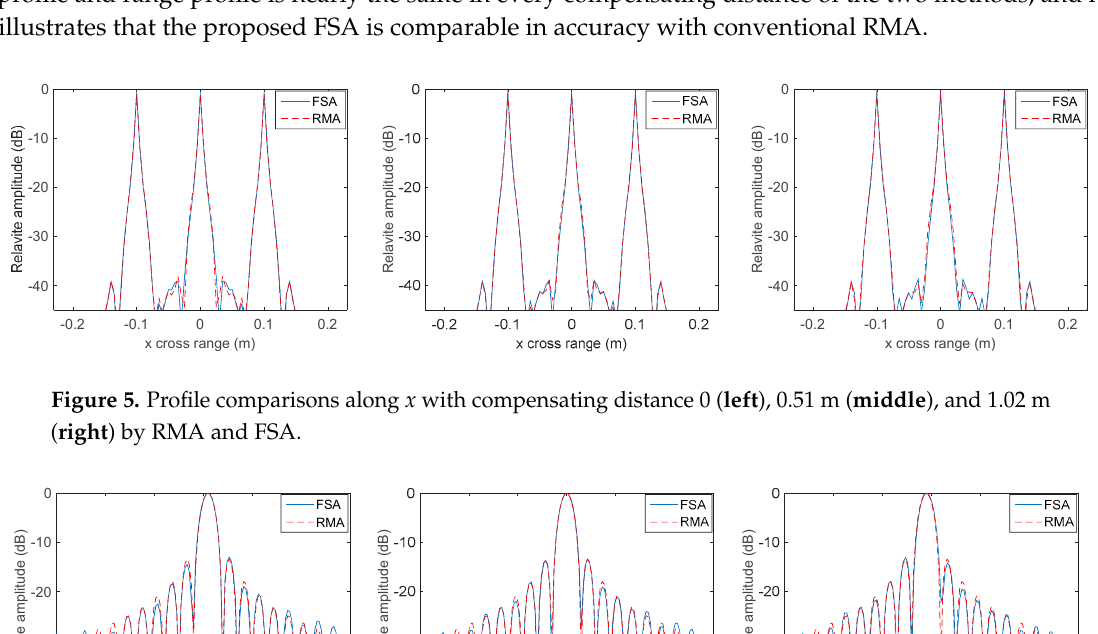
Figure 4. 3-D imaging results of the proposed frequency scaling algorithm (FSA) with compensation distance 0 ( left ), 0.51 m ( middle ), and 1.02 m ( right ).